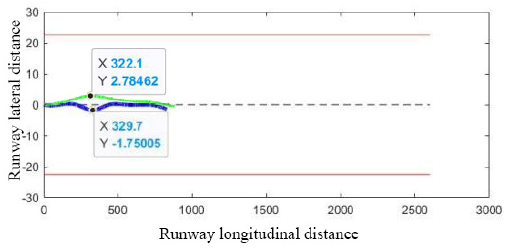
Figure 9. No. 7 take-off slip path.